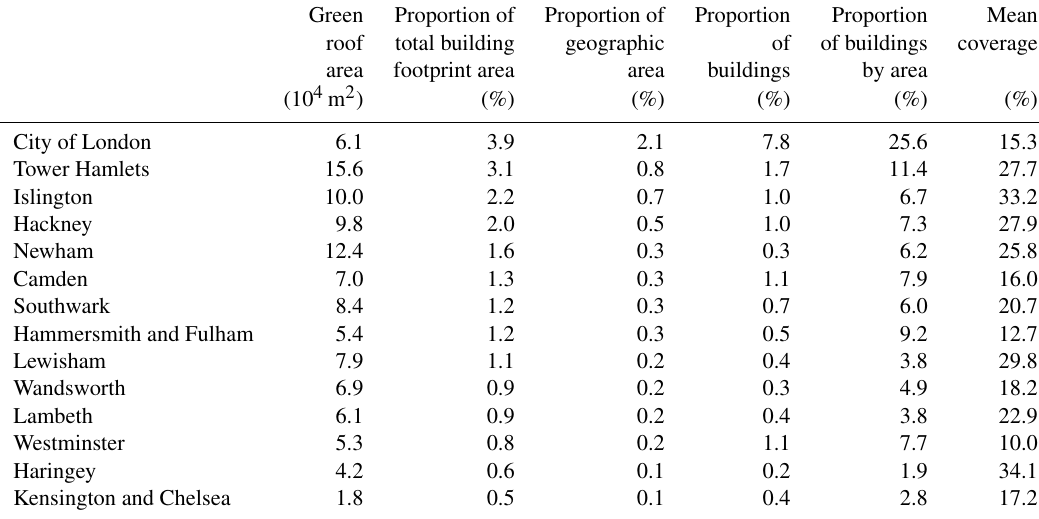
Kensington and Chelsea